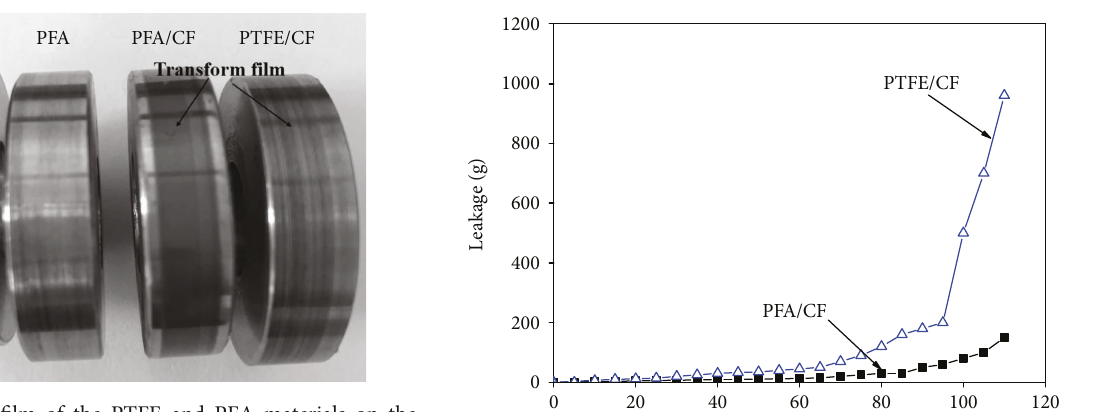
Figure 6: Transfer fi lm of the PTFE and PFA materials on the couple